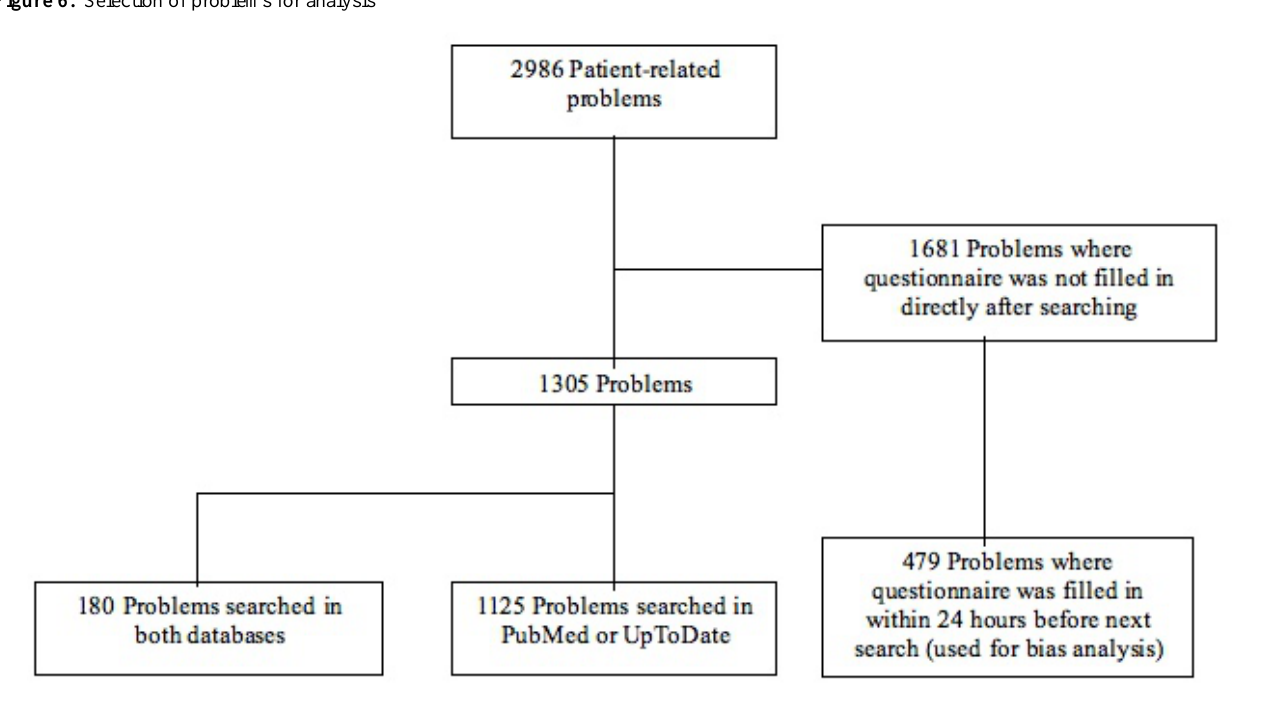
Table 1. Aspects of questions that were sent to only one of the two databases (N = 1125)